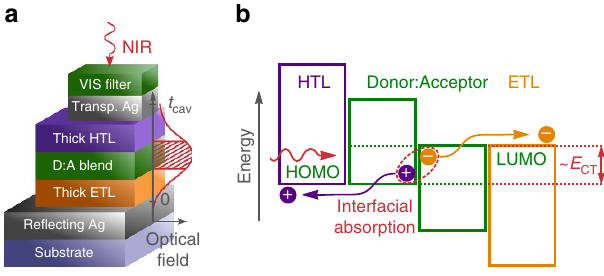
Figure 1 | Working principle of the original cavity enhanced organic photodetector. ( a ) Simplified scheme of the device architecture with a sketch of the optical field distribution for the resonance wavelength in the NIR. The thickness of both transport layers is chosen to achieve constructive interference in the CTabsorption band and to situate the D:A blend layer in the maximum of the optical field. Layer thicknesses are not drawn to scale. ( b ) Simplified energy diagram at open circuit. A photon with less energy than the optical gaps and at least the CT state energy E CT is absorbed at the interface between an electron donating semiconductor and C 60 as acceptor. Thereby, an electron in an occupied state on the donor is promoted into an unoccupied state on the acceptor. The resulting intermolecular CT state dissociates into a free electron and hole which are extracted via the electron (ETL) or hole transport layer (HTL) at the respective Ag